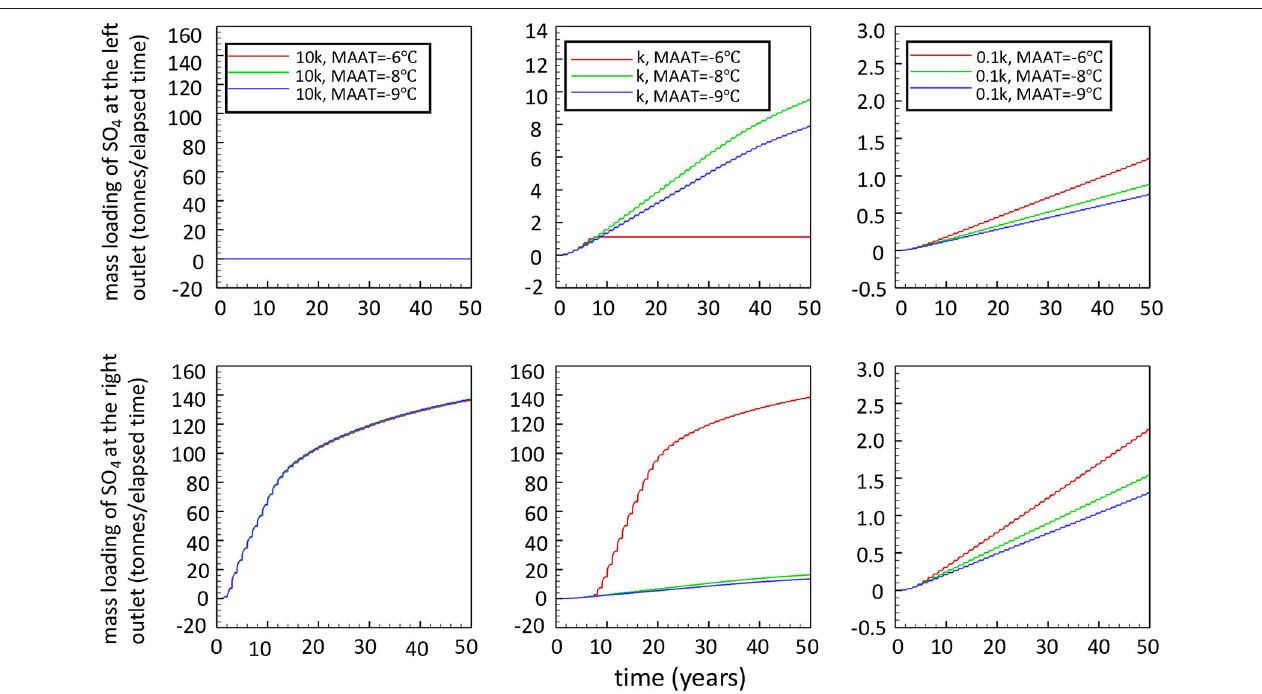
FIGURE 10 | Total sulfate release over elapsed time at the two drainage locations at the toes of the waste rock pile for all scenarios ( k refers to k ref FeS